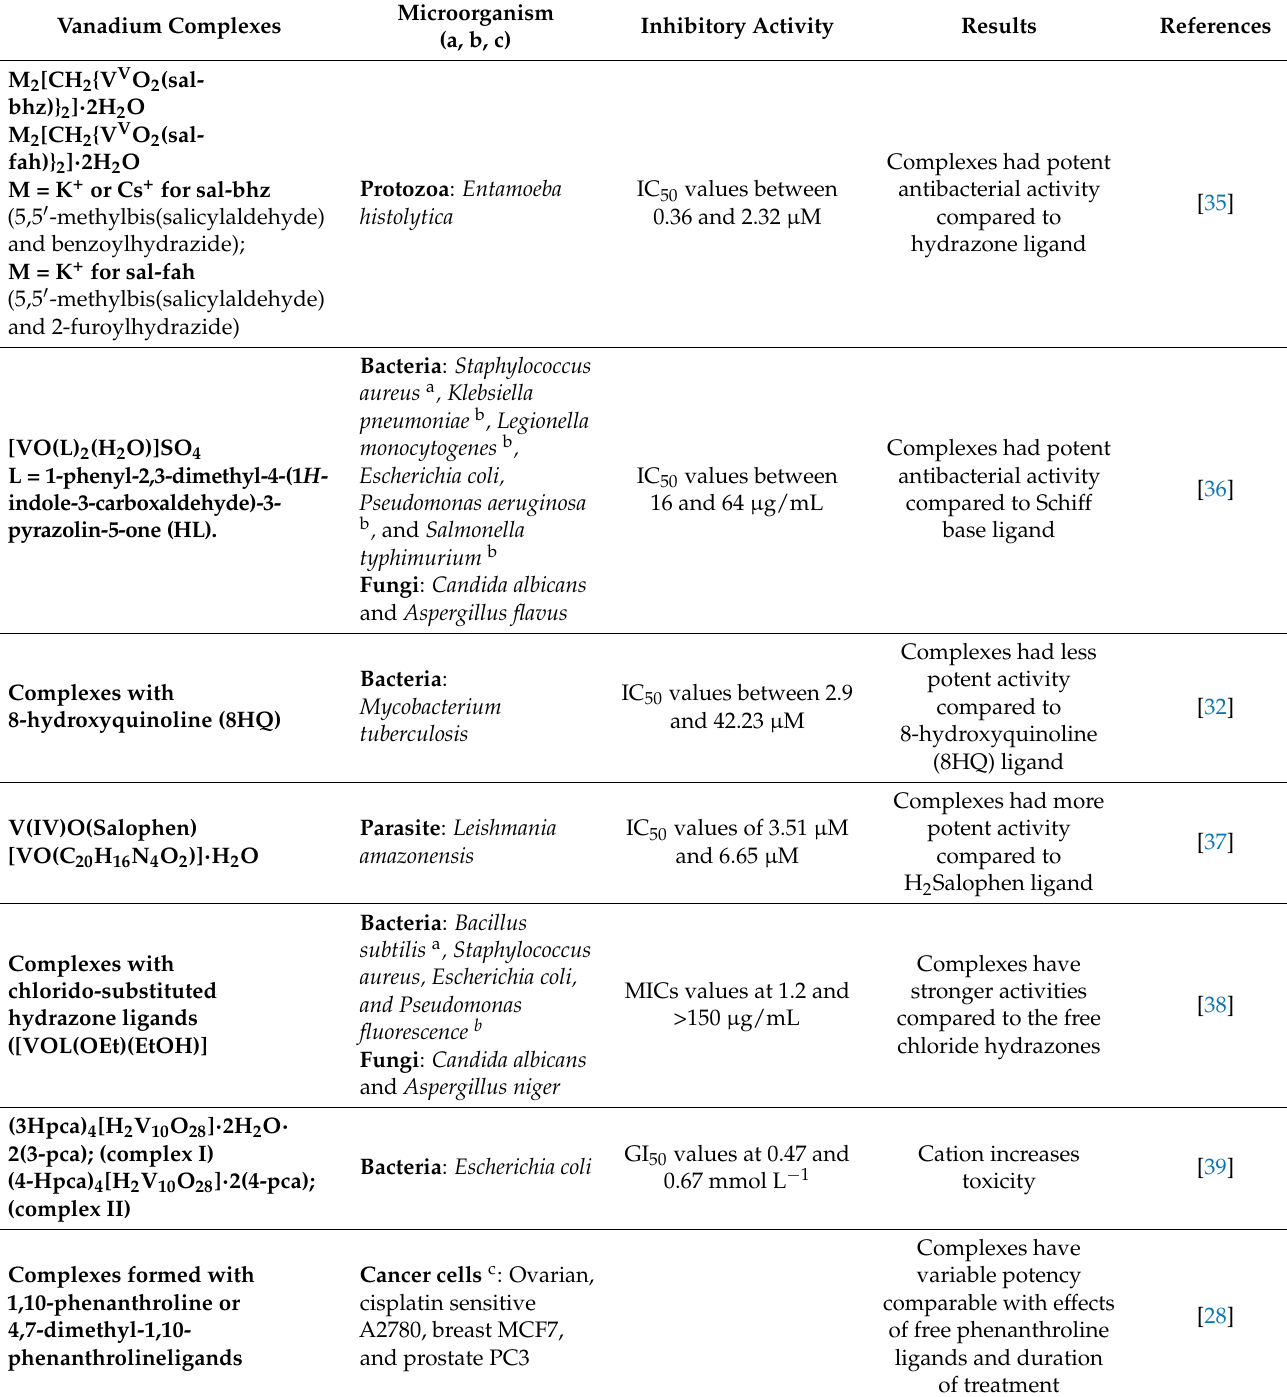
Table 1. Previous studies of the effect of various V-complexes in other